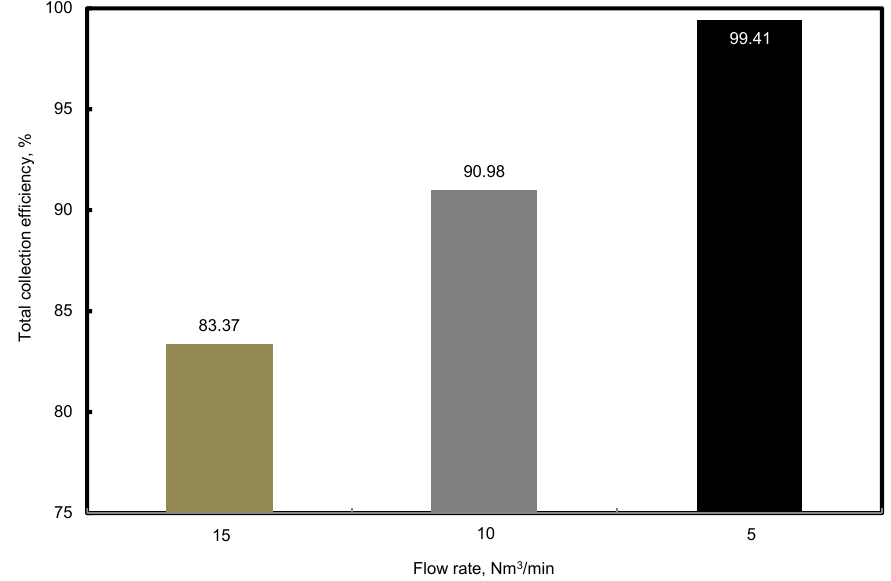
Figure 8. Total collection efficiency results with flow rate variable.